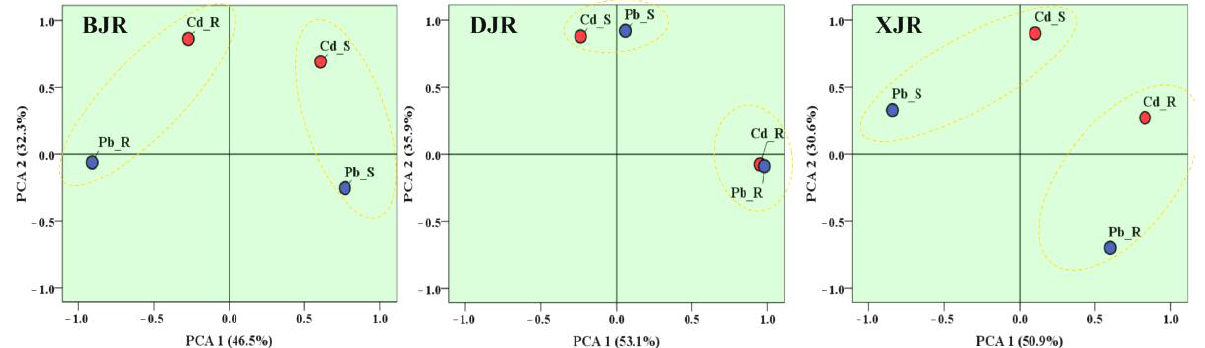
Figure 5. PCA results of Pb and Cd in riparian soils and river sediments from the BJR, DJR, and XJR reaches.